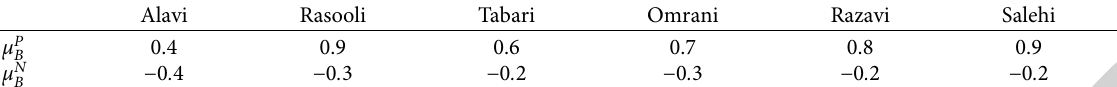
Table 3: The level of staff